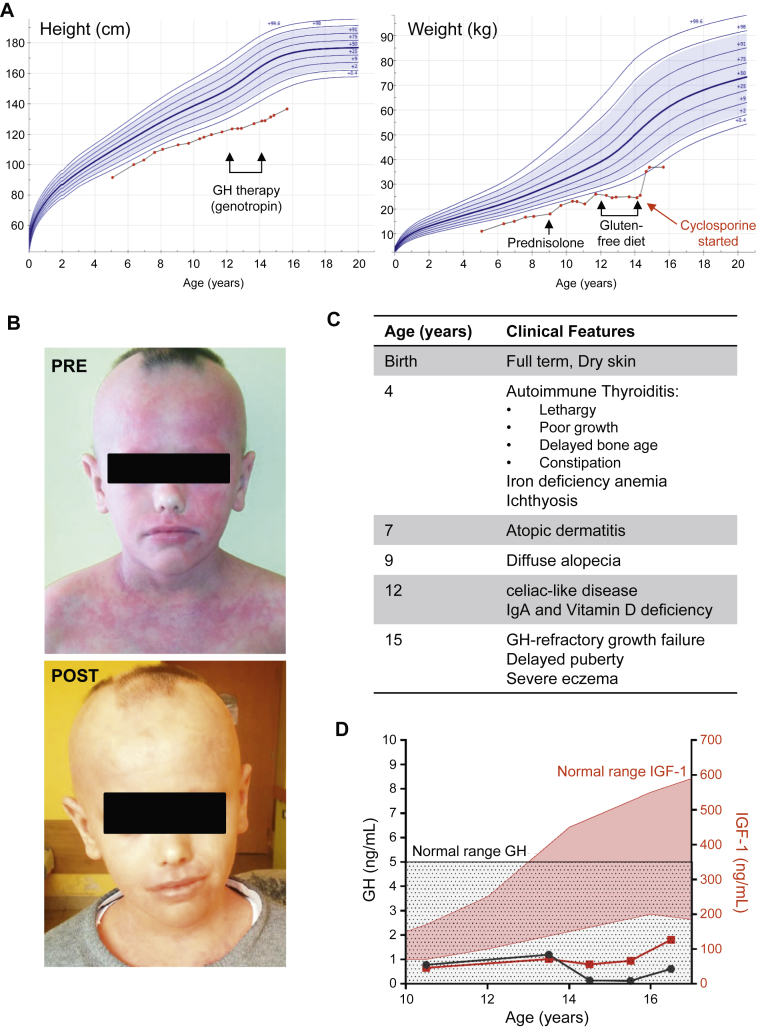
Clinical characteristics. A, Height and weight of the patient from age 5 to 15 years. Periods of GH therapy, gluten-free diet, and steroid treatment are indicated by arrows. B, Eczema and alopecia before (pre) and after (post) cyclosporine treatment. C, Patient clinical features. D, GH (black line) and IGF-1 (red line) levels in the patient over time. Shaded areas: normal ranges (black, GH; red, IGF-1).